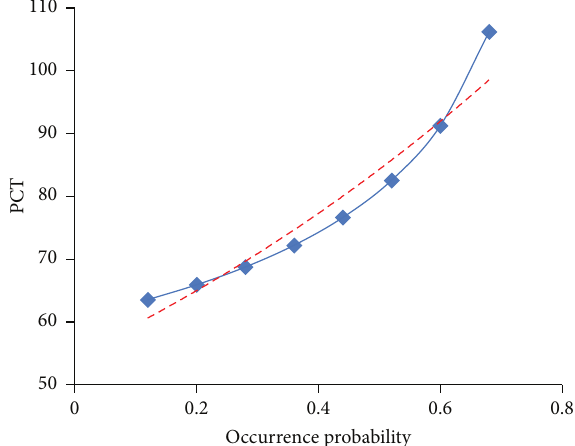
Figure 9: Impact of variation probability of loop occurrence on the PCT.